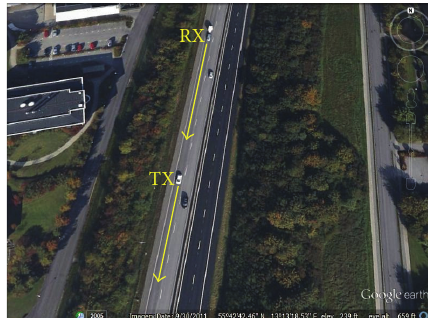
Figure 1: Aerial shot of the measurement route on a highway between the cities of Lund and Malm¨o, Sweden (N 55 ∘ 43 󸀠 46 󸀠󸀠 , E 13 ∘ 14 󸀠 33 󸀠󸀠 ).